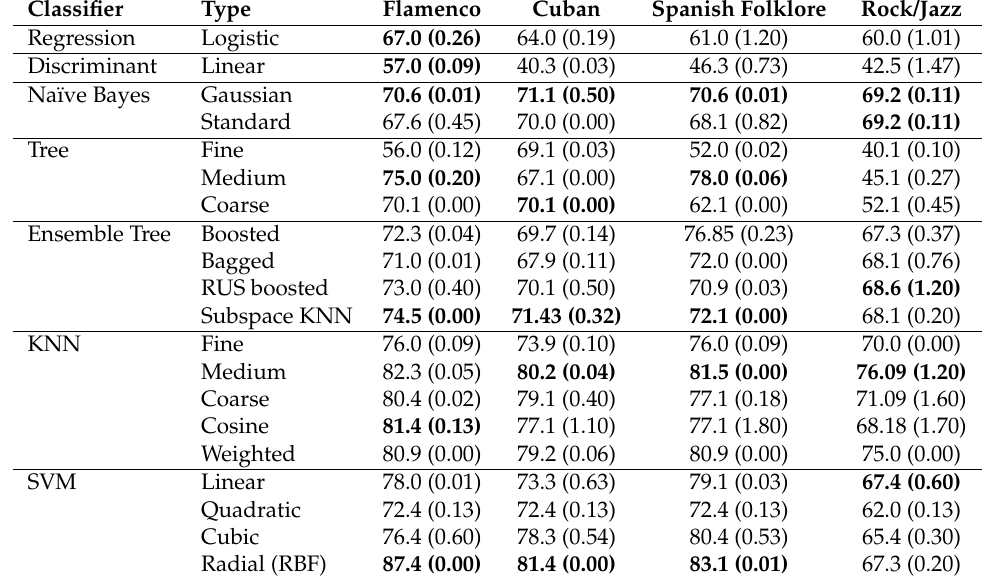
Table 5. Accuracy (%) of arousal assessment through different